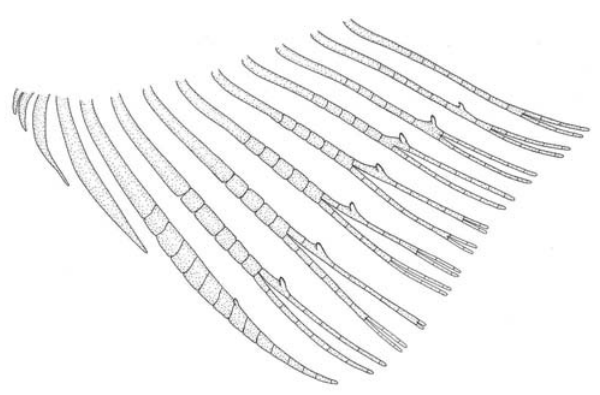
Fig. 39. Mimagoniates barberi , adult male, UMMZ 205420, 32.7 mm SL; anterior 13 anal-fin rays, lateral view, left side.